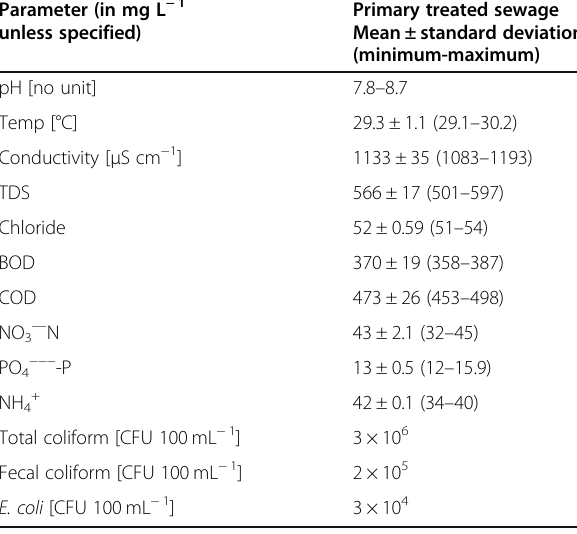
Table 1 Average physico chemical quality of primary treated sewage used for the study Parameter (in mg L −